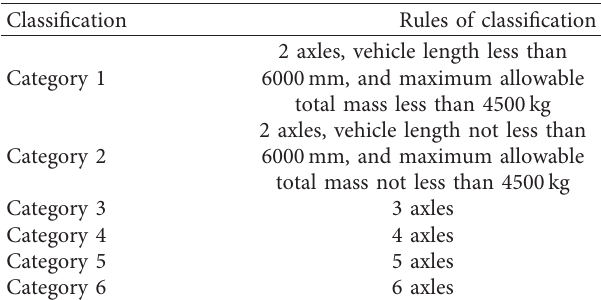
Figure 2: Distribution map of the freeway and first-class highway network in Xinjiang. Table 1: New standard goods vehicle classification in JT/T489- 2019.